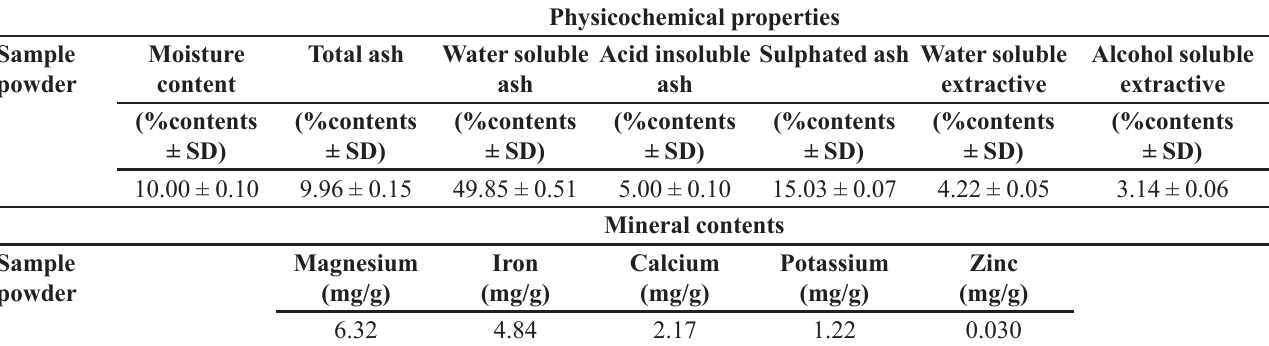
TABLE I - Physicochemical properties and mineral contents of powdered leaves Acacia modesta